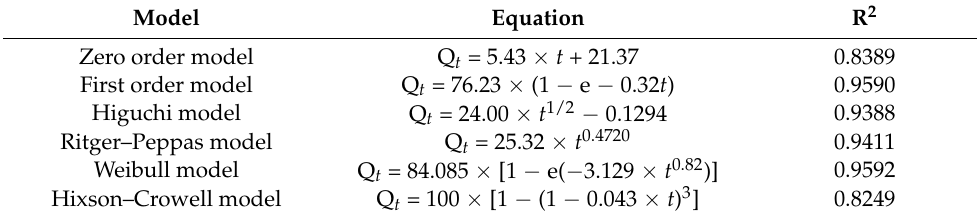
Figure 13. SEM microscopy of RES ( A ), RS ( B ), PEG6000 ( C ), PM ( D ), and RES/RS/PEG6000-SRSD ( E ). Table 5. Release pattern of